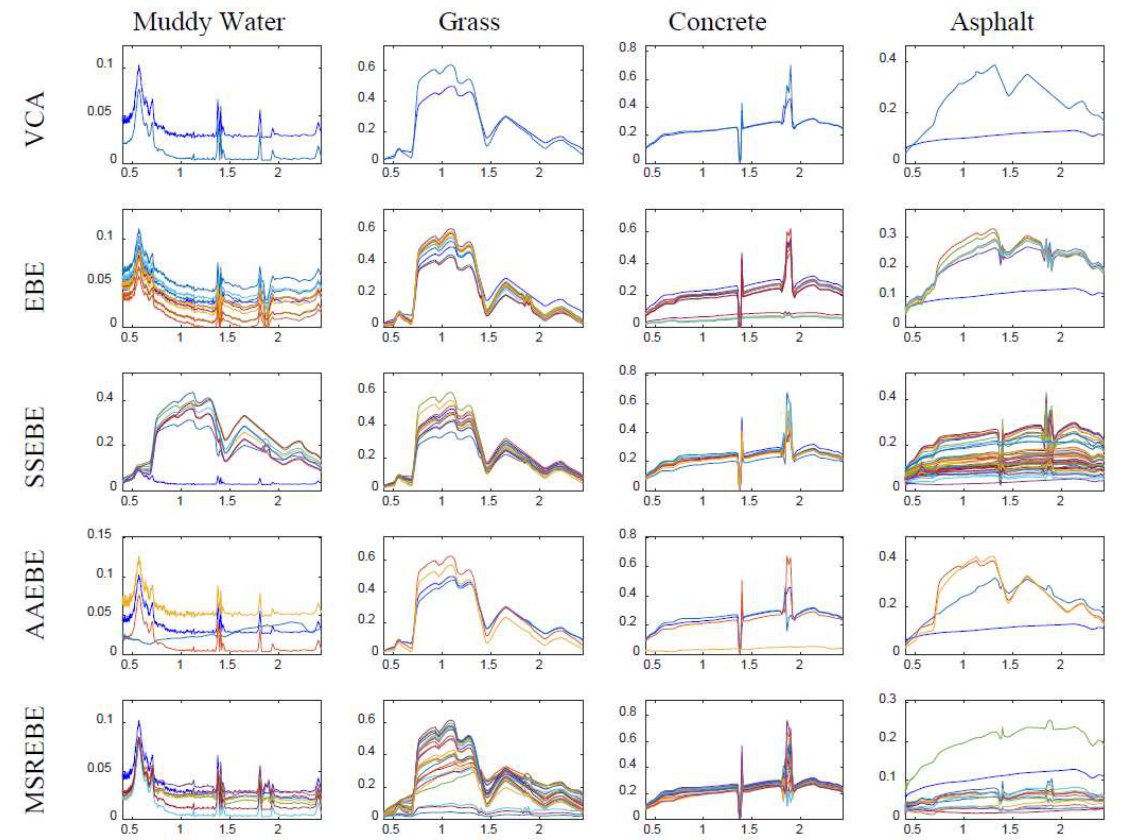
Figure 6. The endmember bundle extraction results of synthetic dataset.